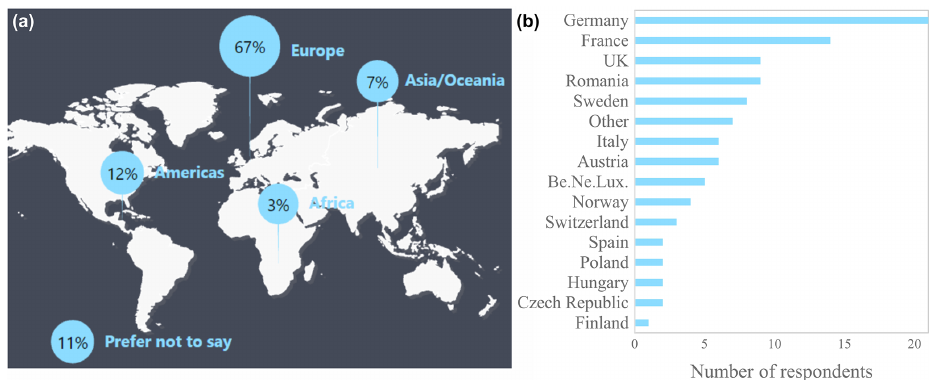
Figure 1. (a) Continent of employment of the 150 respondents, (b) Number of respondents according to the participant’s country of employ- ment in Europe. Be.Ne.Lux corresponds to Belgium, the Netherlands and Luxembourg.